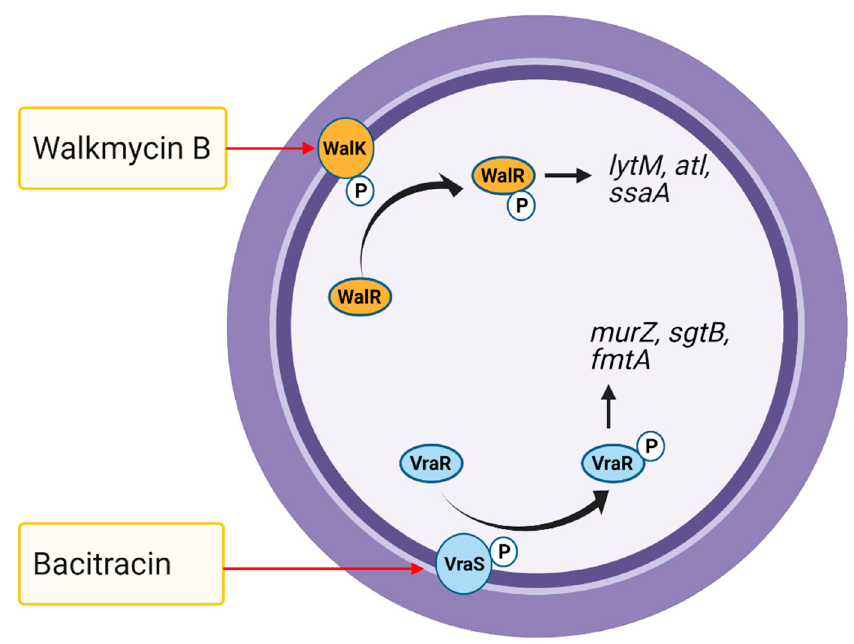
Figure 6. The WalRK and VraRS two-component signal transduction systems (TCSs)-mediated S. aureus response to antimicrobial agents. The effect of walkmycin B (WalK autophosphorylation inhibition) and bacitracin (affect VraRS by uncoupling energy required for ATP synthesis) on S. aureus is shown.